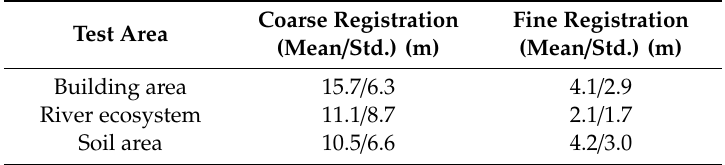
Figure 4. Cloud-to-cloud (C2C) distance (m) maps achieved by coarse registration for ( a ) building area, ( c ) river ecosystem, and ( e ) soil area and fine registration for ( b ) building area, ( d ) river ecosystem, and ( f ) soil area. Table 3. Average and standard deviation of C2C distance (m) of the two point-clouds. Mean refers to the average C2C distance and Std. represents the standard deviation of C2C